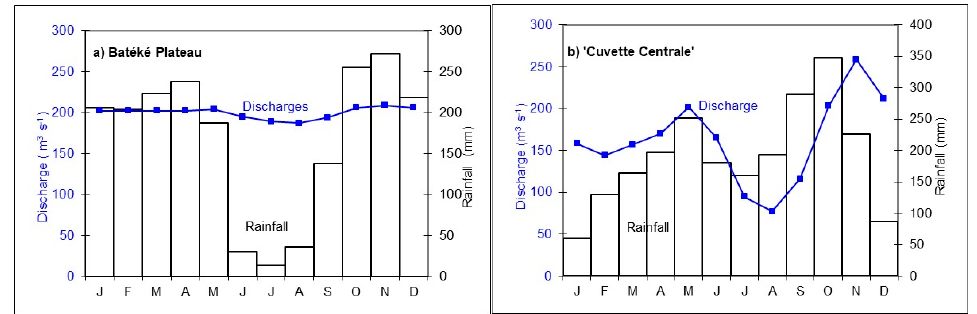
Figure 18. Mean monthly typical rainfall histogram and hydrological regimes of the ( a ) Batéké Plateau and the ( b ) “Cuvette Centrale” (adapted from Laraque et al., 2001) [65].